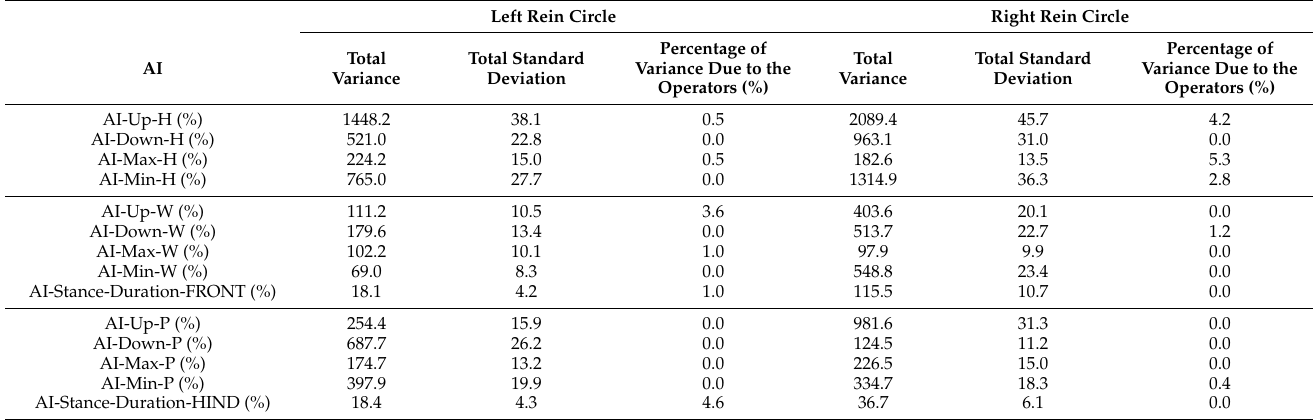
Table 2. Total variance, total standard deviation and percentage of variance due to the operators (calculated out of the total) for four asymmetry indexes (AI -Up, -Down, -Max and -Min) calculated on the head (H), the withers (W) and the pelvis (P) for 48 repeated measurements (4 operators, 3 horses, 4 repetitions) performed on right and left rein